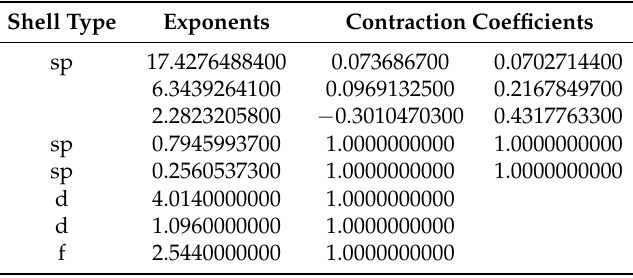
Table A13. Parameters of the cc-TZVP basis set of